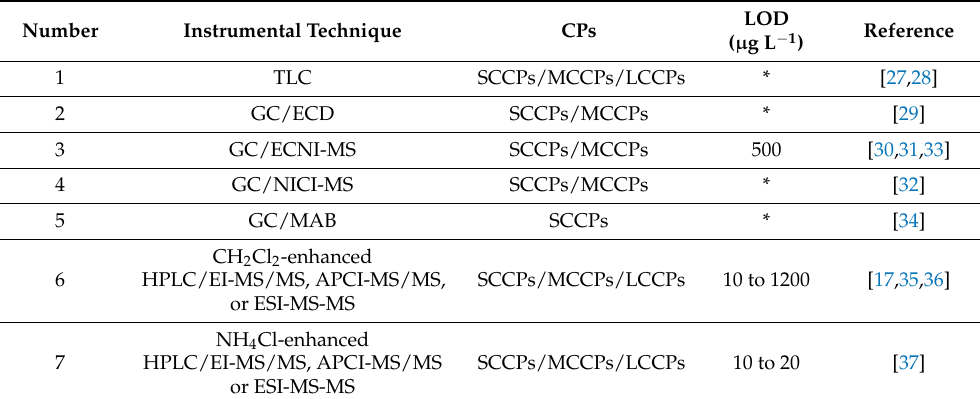
Table 1. Summary of the CPs detection